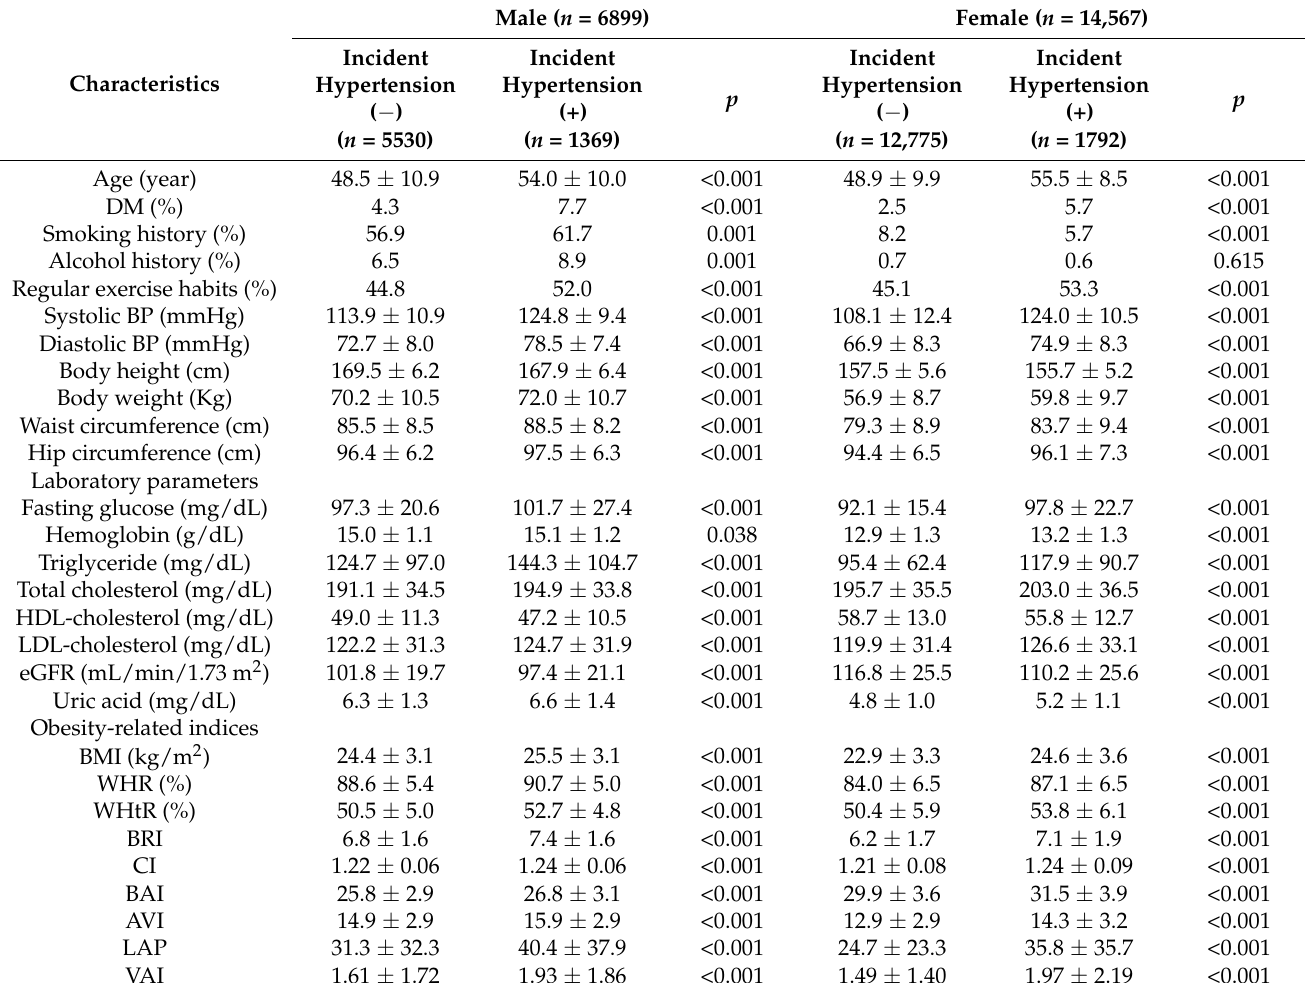
Table 2. Clinical characteristics of the study participants classified by the presence of different sex and incident